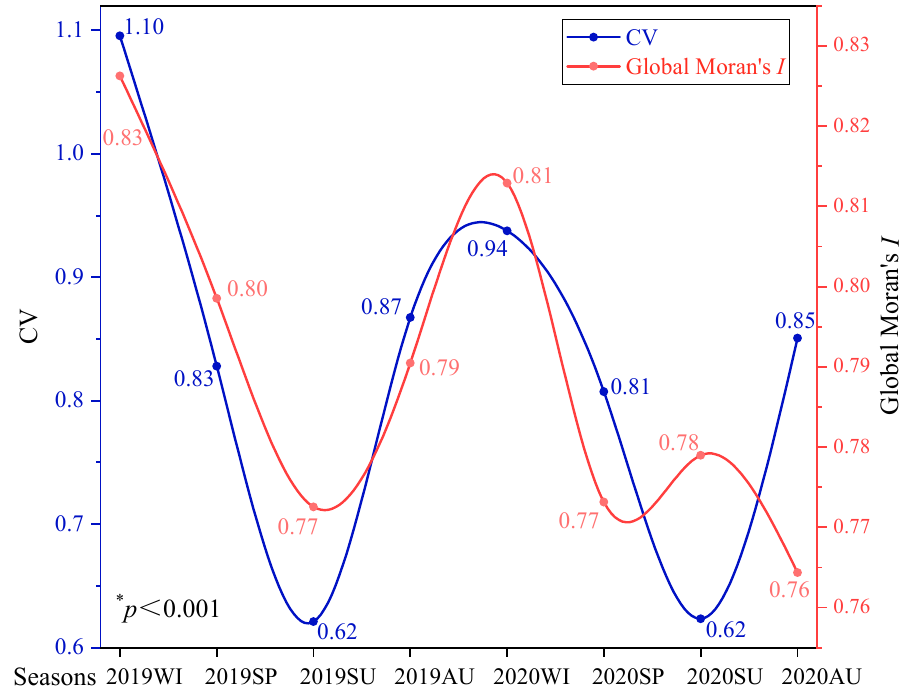
Figure 5. The seasonal CV and the Global Moran’s I at prefectural level in the YREB. Figure 6 shows the identification results of the NO 2 VCD aggregation areas in the YREB in different seasons using the Getis-Ord Gi* method. It shows that the hot spots and cold spots of NO 2 VCD in different seasons of 2019 and 2020 experienced no significant changes. The hot spots of NO 2 VCD were mainly located in Jiangsu, north of Zhejiang, and east of Anhui and Shanghai city, indicating that they were highly NO 2 -polluted areas. The cold spots were mainly located in Yunnan, Guizhou, the western regions of Hubei, Hunan, and Sichuan provinces and most areas in Chongqing city, indicating that they were low-NO 2 VCD aggregation areas.